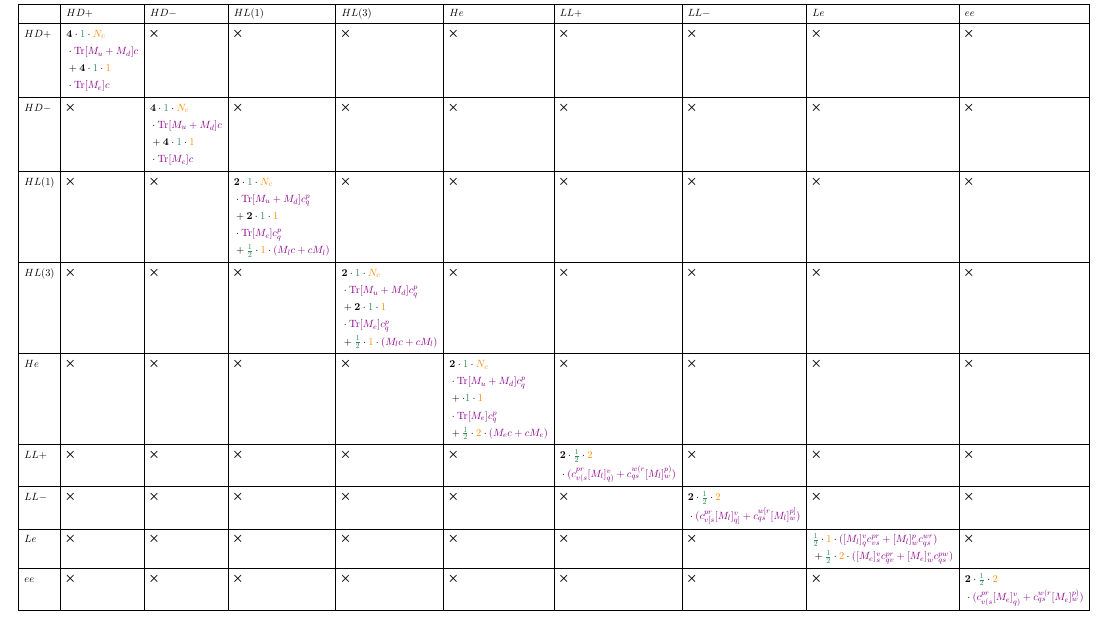
= Y † . Operators are defined in Table 8 . Collinear Yukawa pieces. M Y r , M l = Y e Y † r = u/d/e r e table 11. Phase space factors, given in green, can be found in appendix D and are explained in sections 3.1.3. Gauge factors, given in orange, can be found in tables 2, 13 and 14, and are explained in section 3.2. The flavour factors, in purple, labelled by p, q, r, s indices, can be found in table 3, and are explained in section 3.3. Bold numerical factors are combinatorial: they correspond to several equivalent diagrams, e.g. two or four external legs which can be renormalised in the same way by wavefunction